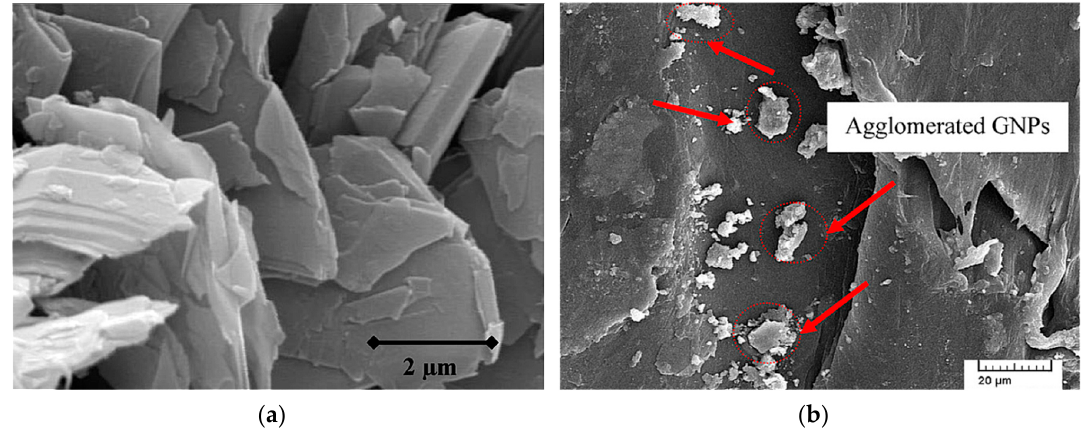
Figure 6. SEM microphotographs of: ( a ) pristine GNP; ( b ) composite filled with 5 wt % GNP showing agglomerated GNPs. Adapted from